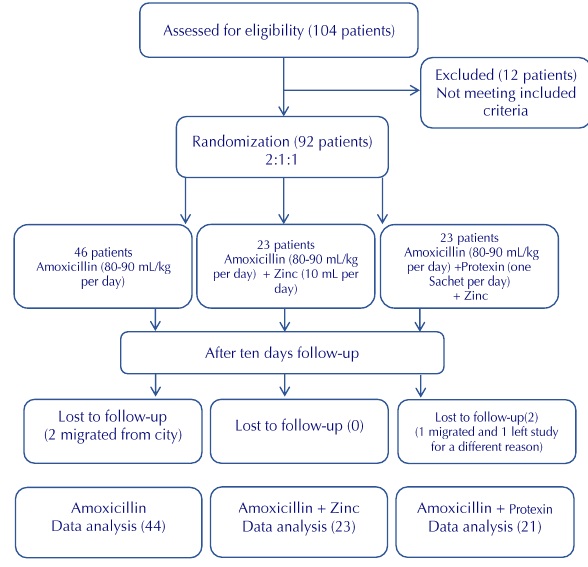
Figure 1. Flowchart of Study